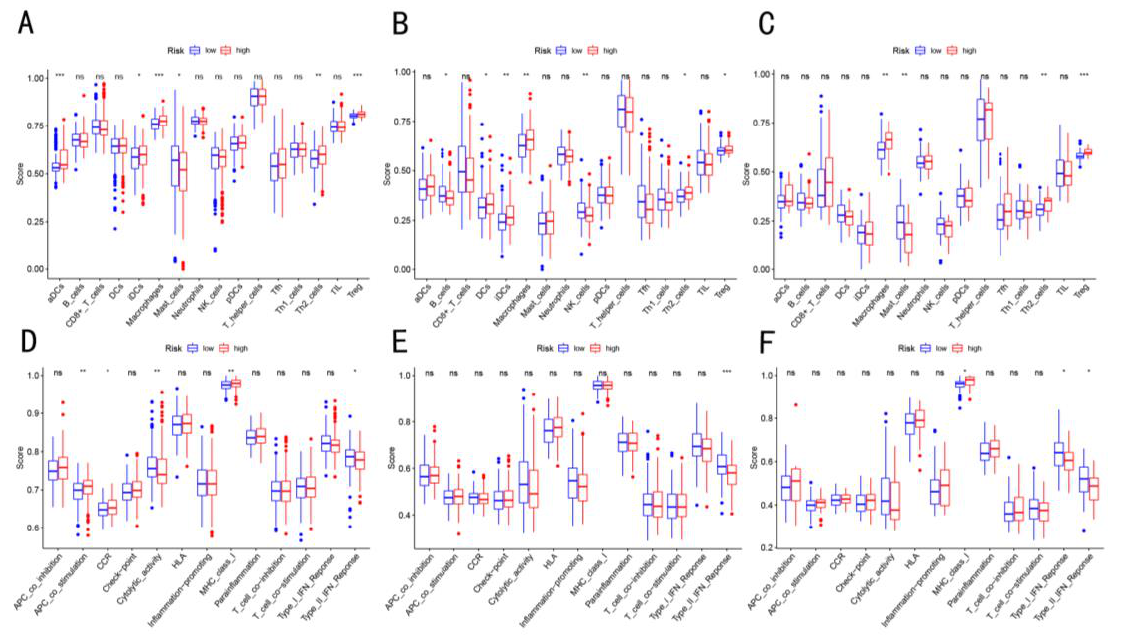
Figure 7. Enrichment scores of immune cell infiltration in the three cohorts. The comparison of the enrichment scores of immune cell infiltration between two risk groups in ( A , D ) TCGA cohort, ( B , E ) ICGC cohort, and ( C , F ) in-house cohort. ( A – C ) Boxplots show scores for multiple immune cells. ( D – F ) Boxplots show scores for multiple immune-related functions. ns, not significant; * p < 0.05; ** p < 0.01; *** p < 0.001.